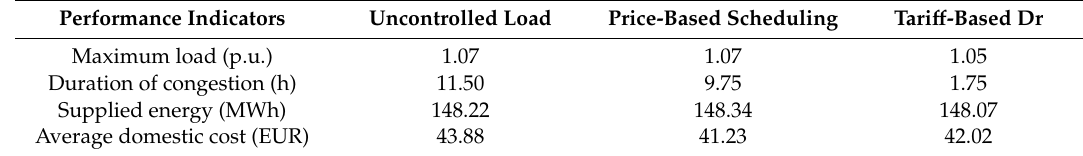
Table 1. Comparative monthly assessment among di ff erent